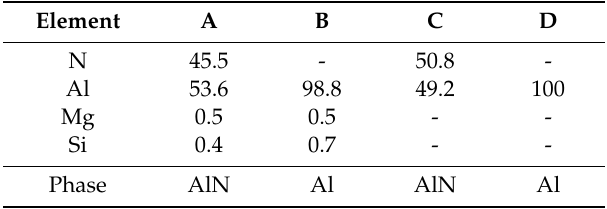
Table 1. Energy-dispersive spectroscopy (EDS) results of the spots in Figure 4 (at. %). Element